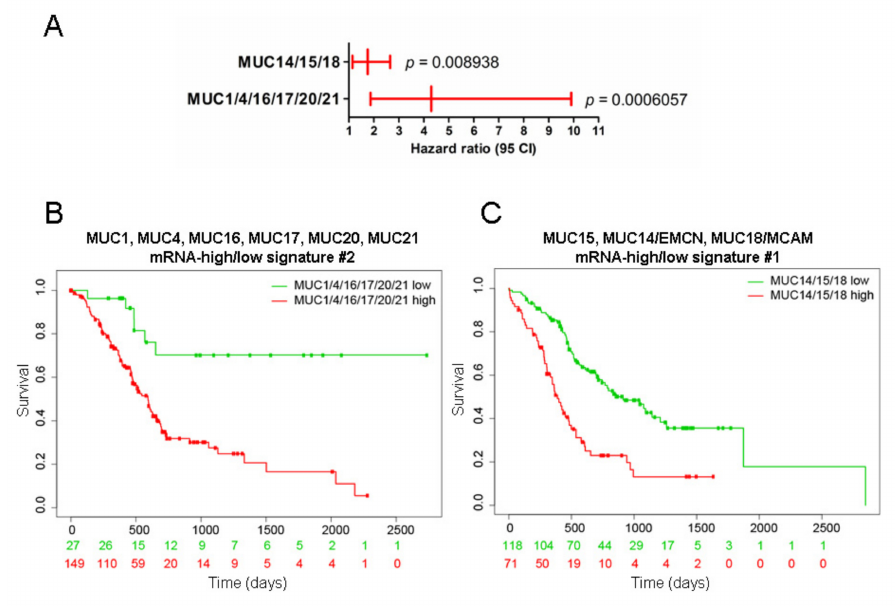
Figure 7. Analysis of overall survival of the #1 and #2 mucin signatures in pancreatic cancer datasets using SurvExpress. ( A ) Hazard ratio according to signature #1 ( MUC1 , MUC4 , MUC16 , MUC17 , MUC20 , and MUC21 ) and #2 ( MUC14 / EMCN , MUC15 , and MUC18 ) high and low expression in the pancreatic adenocarcinoma PAAD cohort. ( B ) PAAD patients were stratified using a gene signature combining MUC1, MUC4 , MUC16 , MUC17 , MUC20 , and MUC21 . Kaplan–Meier curves were analyzed using the optimized SurvExpress Maximize algorithm. The number of analyzed patients across time (days) is indicated below the horizontal axis for both conditions. ( C ) PAAD patients were stratified using a gene signature combining MUC15 , MUC14 / EMCN , and MUC18 / MCAM using the Maximize